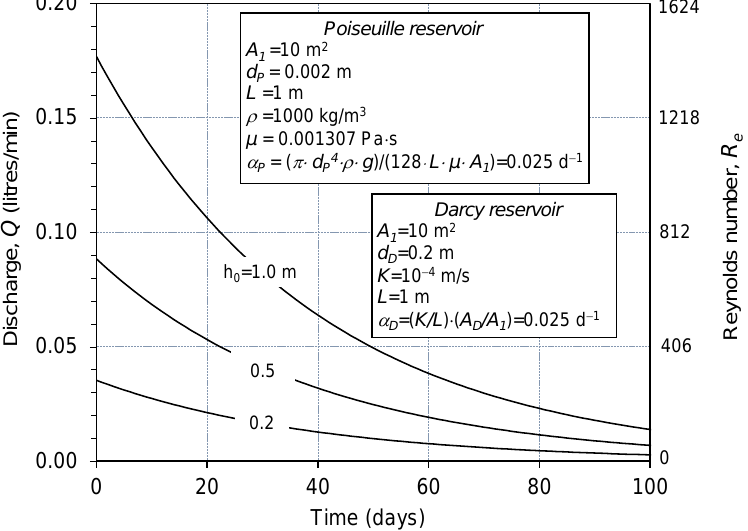
Figure 2. Discharge-time plot for different initial water level, h 0 , using the Darcy reservoir and the Poiseuille reservoir with the same recession coefficient ( 𝛼 𝐷 = 𝛼 𝑃 ). The Reynolds number, R e , refers to the flow into the tube of the Poiseuille reservoir.